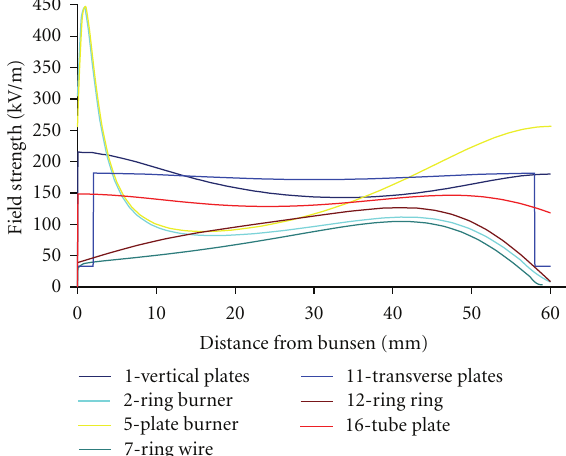
Figure 7: Enlargement of flame region.